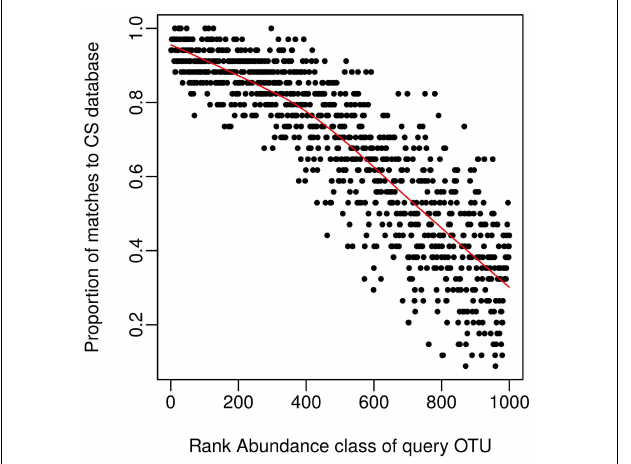
FIGURE 2 | The CS database provides good coverage of dominant taxa within a query dataset. Query OTU reference sequences (dataset 1, Table 1 ) were grouped into 1,000 bins by decreasing rank (e.g., the 1000th bin contains the least abundant OTUs); and the proportion of each bin matching the CS dataset calculated and displayed on the y -axis. The proportion of matches to the CS database ( > 97% similarity) declines as query taxa become rarer, despite the comprehensive nature of the CS